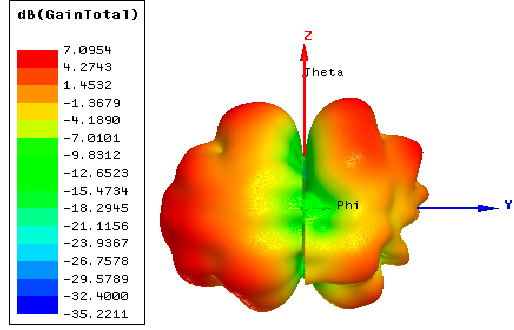
Figure 6. 3D polar plot at 2.4 GHz when A = 90°.